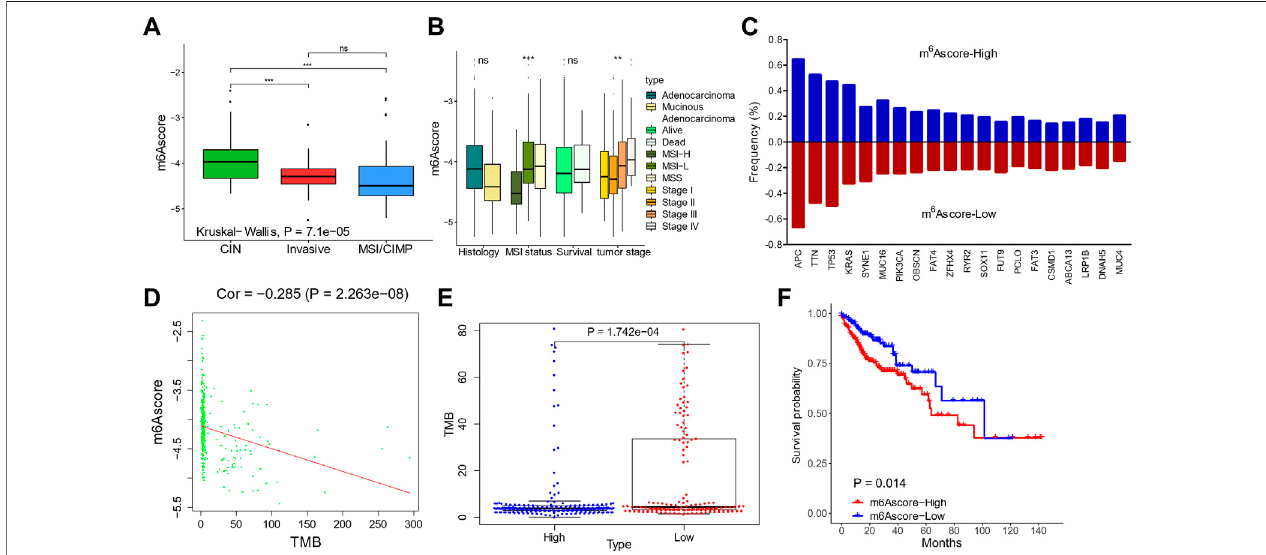
FIGURE 6 | Validation of m 6 Ascores in The Cancer Genome Atlas (TCGA) cohorts. (A,B) m 6 Ascores in patients with different molecular subtypes (A) and clinical features (B) . (C) Genomicmutationratesofthetop20genesinpatientswithhighandlowm 6 Ascores. (D) Correlationbetweenm 6 Ascoresandtumormutationburdens. (E) Tumor mutation burdens in patients with high and low m 6 Ascores. (F) Kaplan – Meier curves of m 6 Ascores.